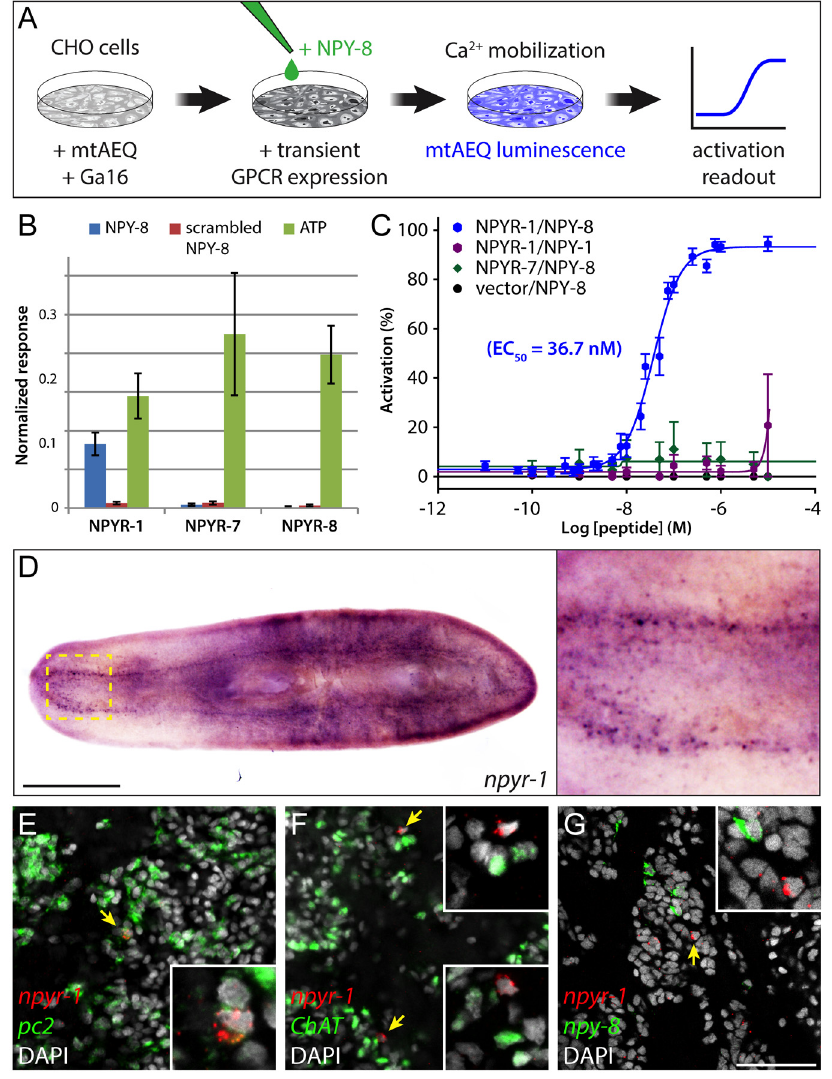
Fig 3. NPY-8 targets npyr-1 + neuroendocrine cells in the CNS. (A) Schematic of receptor-activation assay performed in CHO/mtAEQ/G16 cells. Candidate GPCRs were expressed transiently in a cell line that enables visualization of calcium mobilization upon receptor activation. (B) Normalized activation response of CHO cells expressing NPYR-1 or control receptors, challenged with NPY-8 or control peptides. NPY-8 specifically activates NPYR-1, while two other NPY receptors (NPYR-7 and NPYR-8) are not activated upon NPY-8 treatment. Scrambled NPY-8 was used as a negative control. Calcium responses were normalized to the total calcium response after addition of 0.1% Triton X-100. ATP, which activates an endogenous CHO receptor, was used to test the functionality of the assay. Peptides and ATP were tested at 10 and 1 μ M, respectively. (C) Concentration-response curves for the activation of NPYR-1 by NPY-8 and control peptides. Data are shown as a percentage of the highest normalized response of the concentration series. NPY-8 activates NPYR-1 at EC 50 = 36.7 nM (blue). Closely related NPY-1 fails to activate NPYR-1 (purple). Empty pcDNA3.1 vector and NPYR-7 were used as negative controls. Error bars in B and C represent standard error of the mean (SEM) ( n (cid:3) 4). The underlying data for receptor assays can be found in S4 Data. (D) Colorimetric ISH showing expression of npyr-1 in a subset of cells in the brain and along the ventral nerve cords. Inset shows the brain region at higher magnification. (E – G) Double-FISH labeling npyr-1 (red) and other neural markers (green). npyr-1 + cells express neuroendocrine cell marker pc2 (E, 28/30 express pc2 ) but not the cholinergic neuronal marker ChAT (F, 0/30 express ChAT ). npy-8 and npyr-1 are expressed in distinct populations of cells (G, 0/30 npyr-1 cells express npy-8 and 0/30 npy-8 cells express npyr-1 ). DAPI (grey) labels nuclei. Scale bars are 1 mm in D and 50 μ m in E – G.